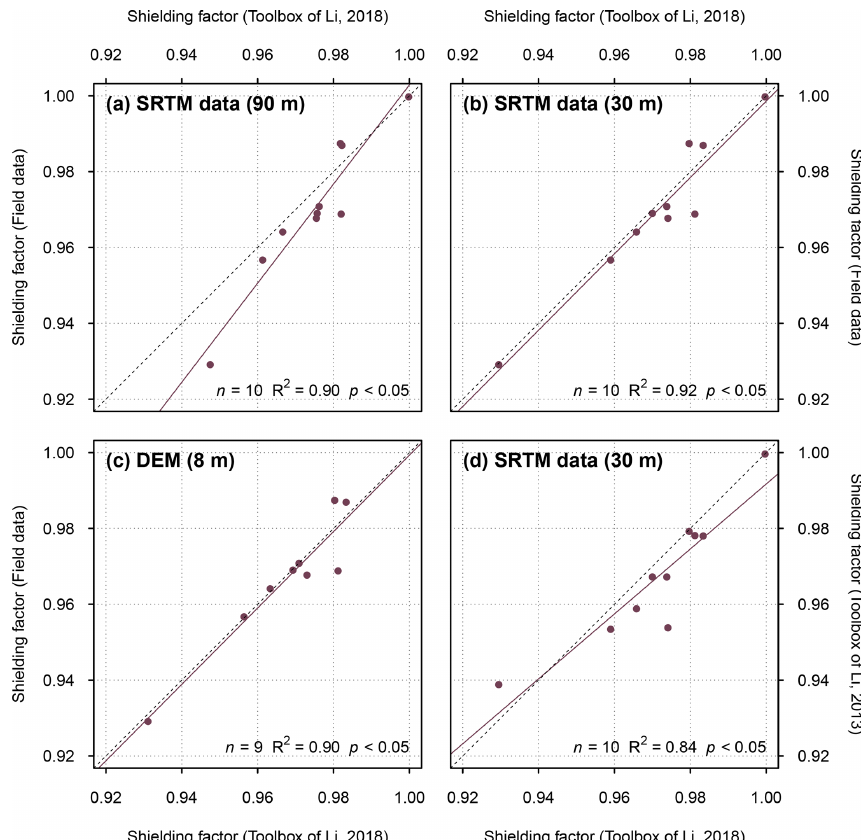
Figure A2. Topographic shielding factors for 10 sampling locations in the Ürümqi catchment in Tian Shan, China, computed with (a) SRTM data, (b) SRTM elevation data with a higher spatial resolution and (c) with the High Mountain Asia DEM (Shean, 2017) versus field- data-based topographic shielding factors. Note that one sampling site is not covered by the High Mountain Asia 8m DEM, and thus the topographic shielding factor was only determined for nine boulders (Li, 2018). (d) Topographic shielding factors determined with the toolbox of Li (2018) versus the topographic shielding factors derived with an older toolbox (Li, 2013). The strike, dip and height of the sampling surfaces above ground were set to zero in the new toolbox, as the older one does not takes these variables into account (Li, 2018). All correlations are statistically significant when choosing α = 0 . 05 as significance level. The solid and dotted lines are the linear models and 1:1 lines, respectively. The numbers in parentheses refer to the spatial resolution of the elevation data. Data from Li